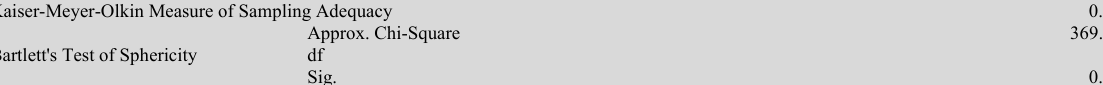
KMO and Bartlett's Test